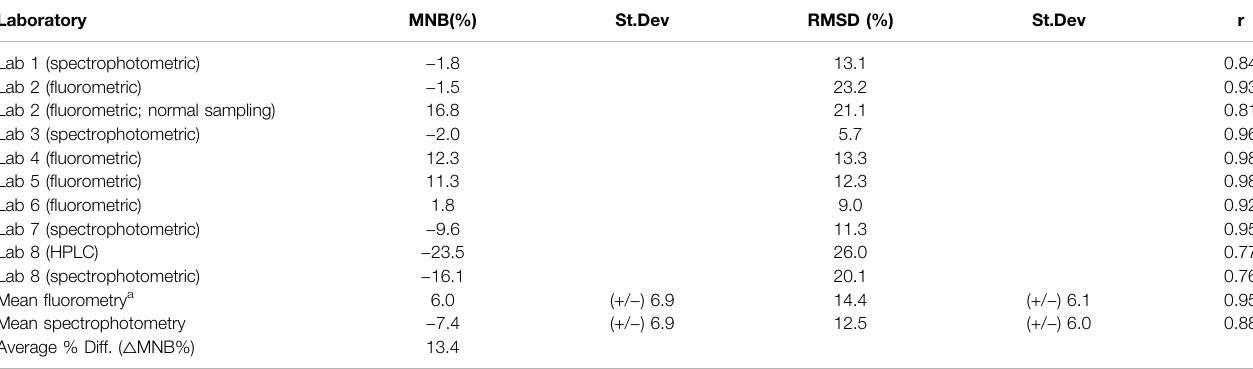
TABLE 2 | Statistical results of the correlation analyses (each laboratory was assessed against the median of all spectrophotometric and fl uorometric laboratories). Any differences ≥ 20% are highlighted in bold and may need addressing. Note that the HPLC method was found to be 23% below all spectrophotometric and fl